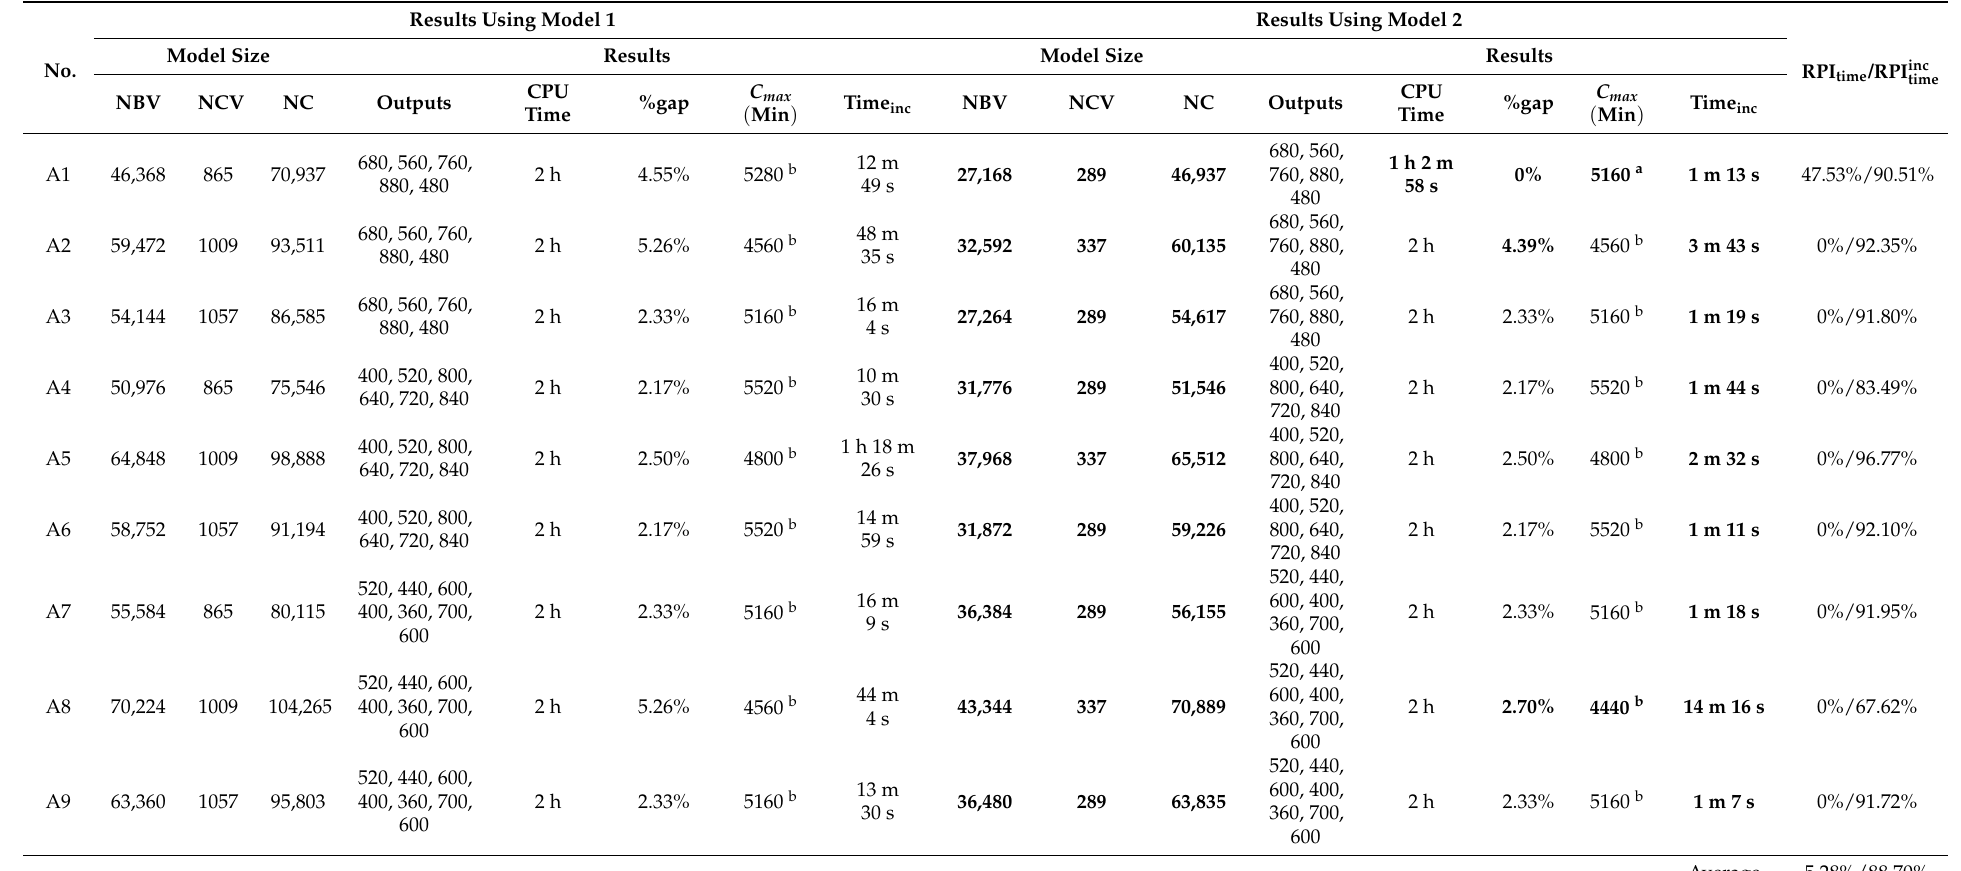
Table 13. Computational results of the additional test problems using Model 1 and Model